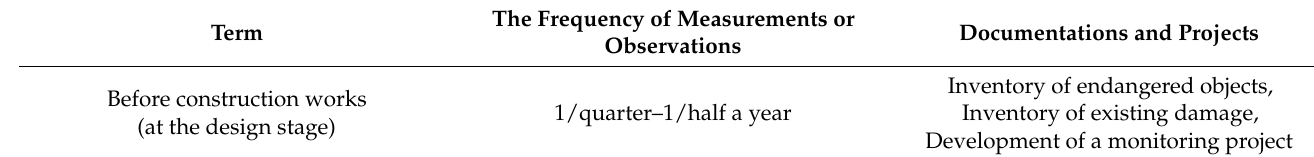
Table 2. Good practice rules in monitoring of structures adjacent to construction